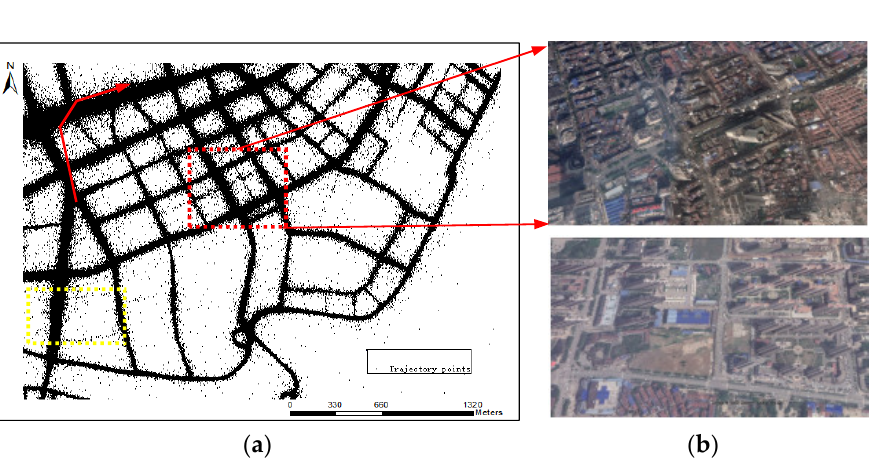
Figure 1. The road network example. ( a ) Trajectory distribution in Hankou old downtown areas (red line is a single trajectory); ( b ) remote sensing images of Hankou old downtown areas and new downtown areas in Jiangxia.